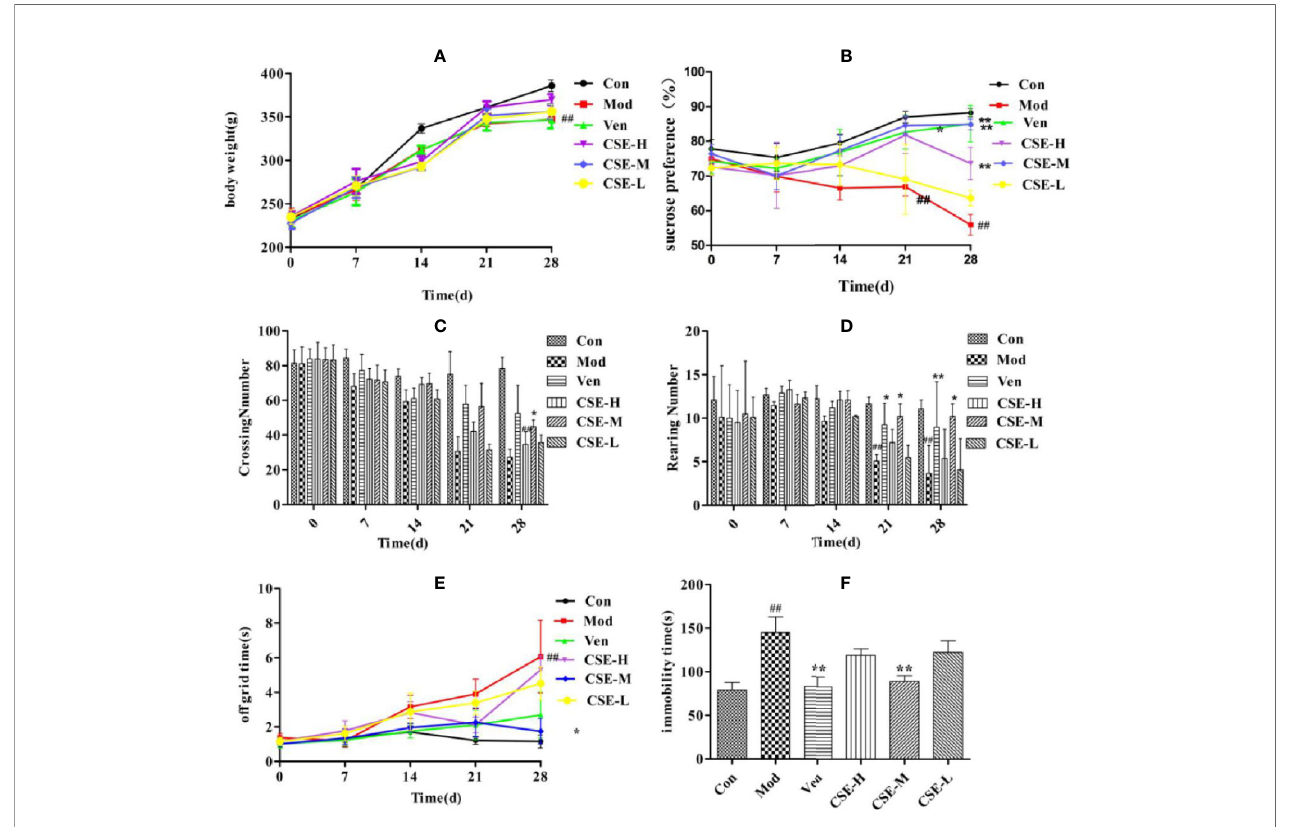
FIGURE 4 | The effects of coumaroylspermidines extract (CSE) on body weight of CUMS rats (A) , sucrose preference (B) , crossing number (C) , rearing number (D) , off grid time (E) , and FST (F) . Values given are the mean ± SEM (n = 10). ## P < 0.01 compared with the control group. **P < 0.01, *P < 0.05 compared with the model group. (Con: control group, Mod: model group, Ven: venlafaxine group, CSE-H: CSE high group, CSE-M: CSE middle group, CSE-L: CSE low